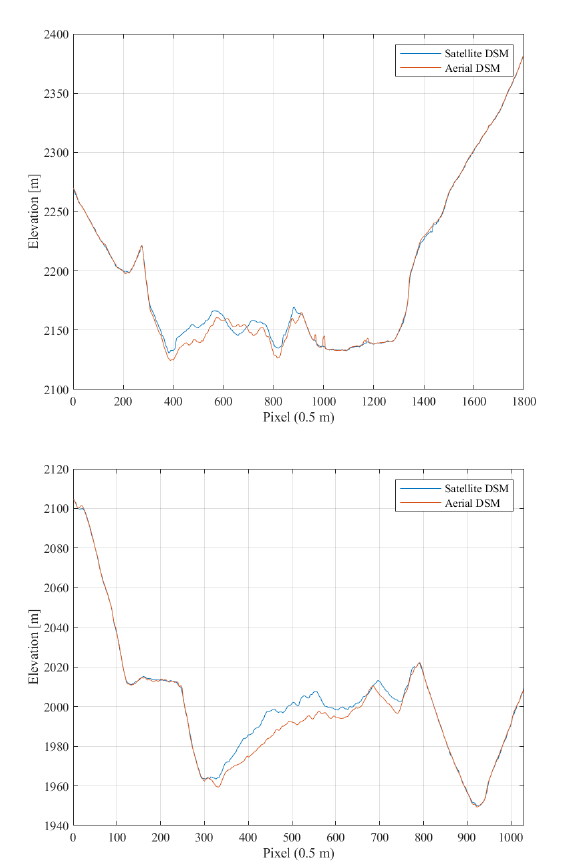
Figure 13 – 2019 aerial (red) and 2017 satellite (blue) DSM elevation profiles 1 (top) and 2 (bottom), transects in Figure 10